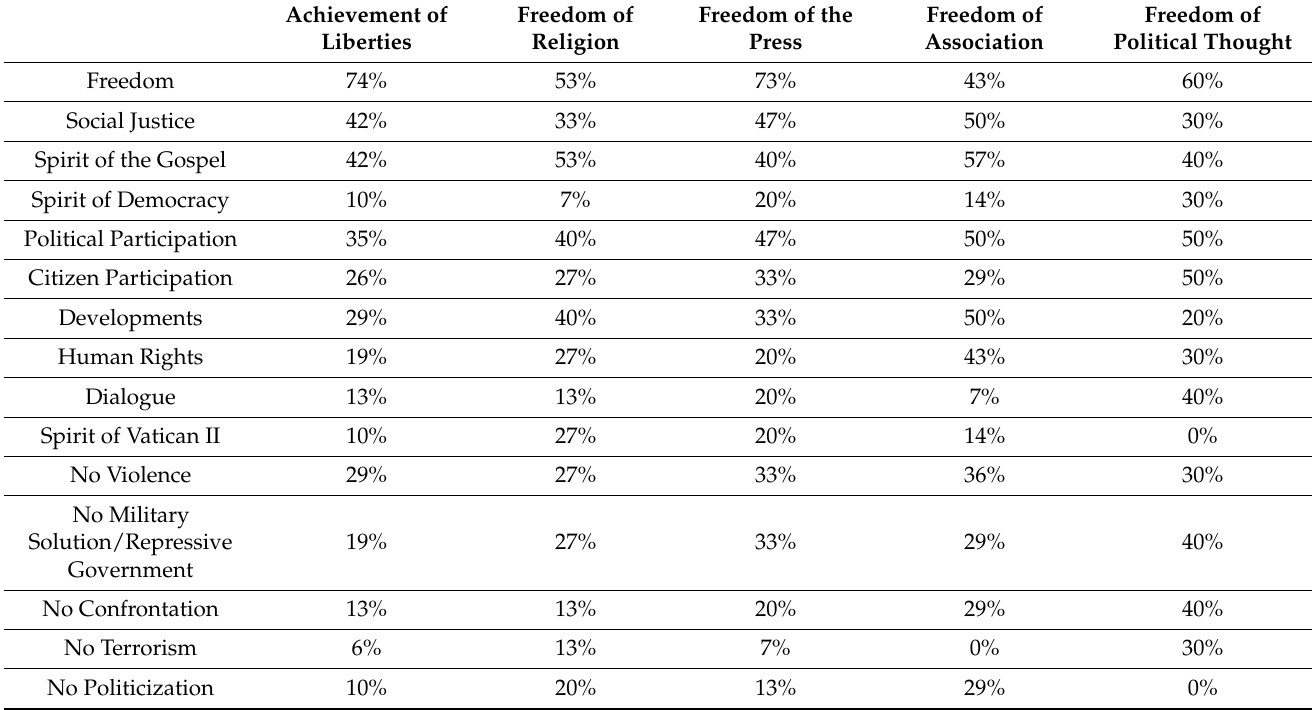
Table 2. Co-occurring percentages of categories with editorial content